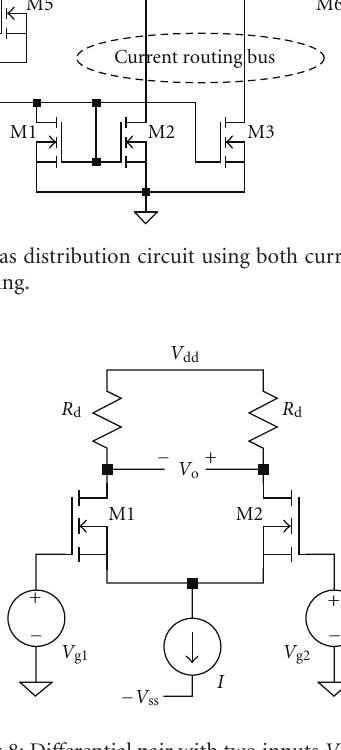
Figure 8: Di ff erential pair with two inputs V g1 and V g2 .